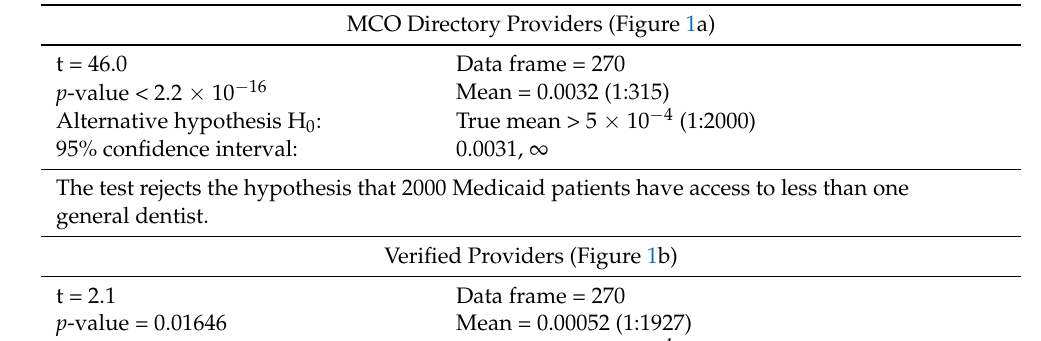
Table 5. One-sample t -test results.